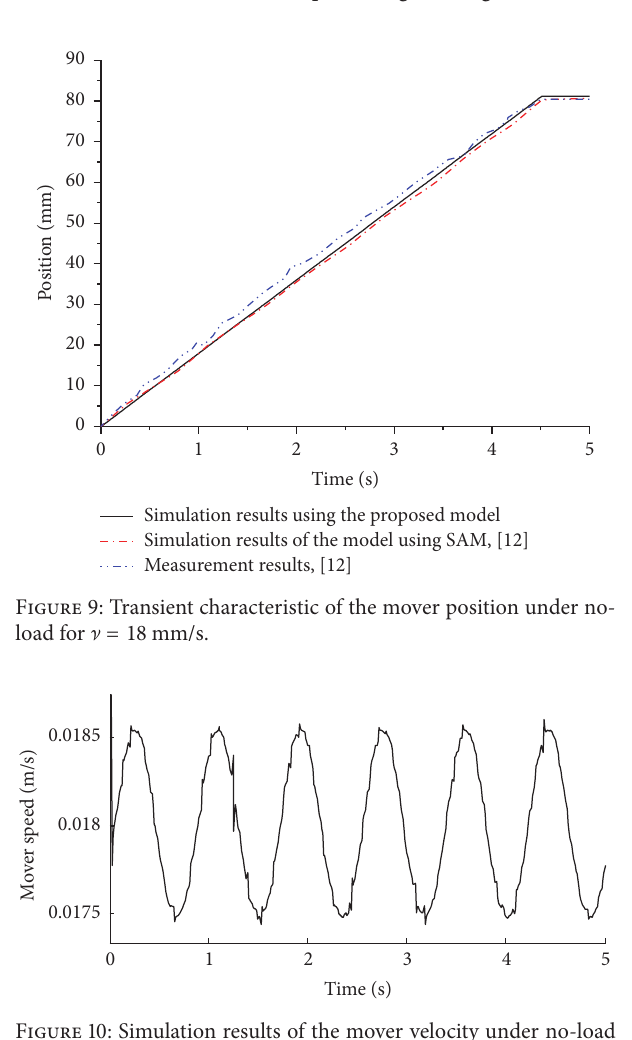
Figure 10: Simulation results of the mover velocity under no-load for ] = 18 mm/s.